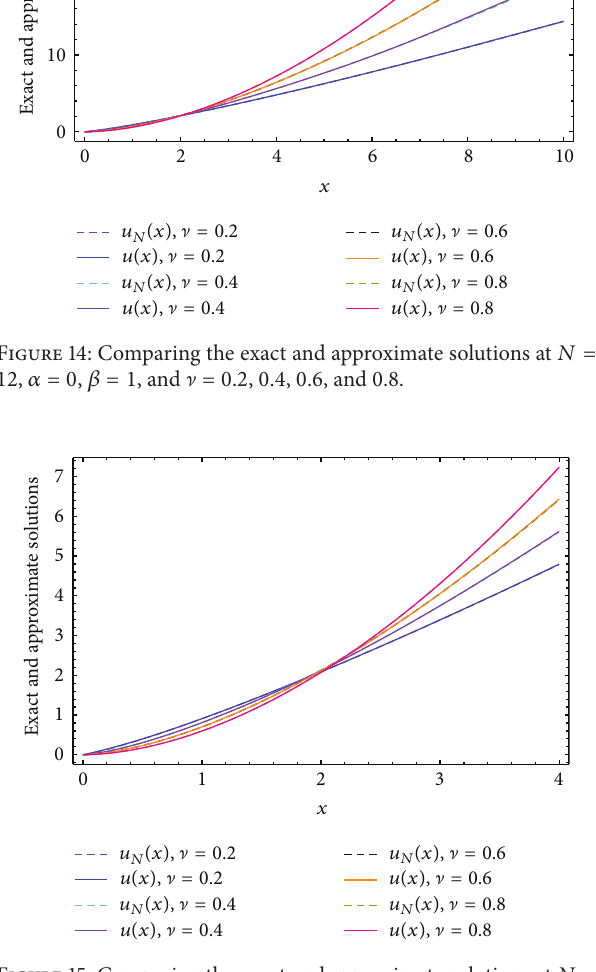
validity and applicability of the method. The computational results show that the proposed methods can be effectively used in numerical solution of time-dependent fractional partial differential equation and other problems on the half